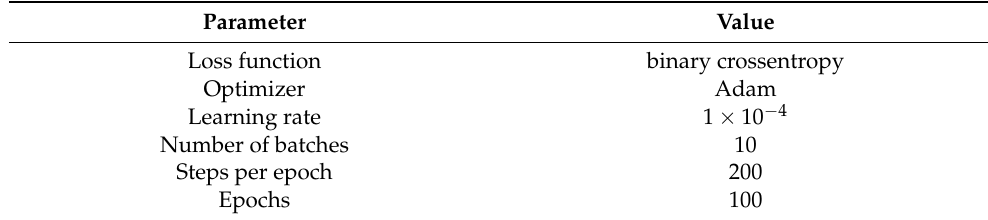
Table 2. Summary of parameters used for